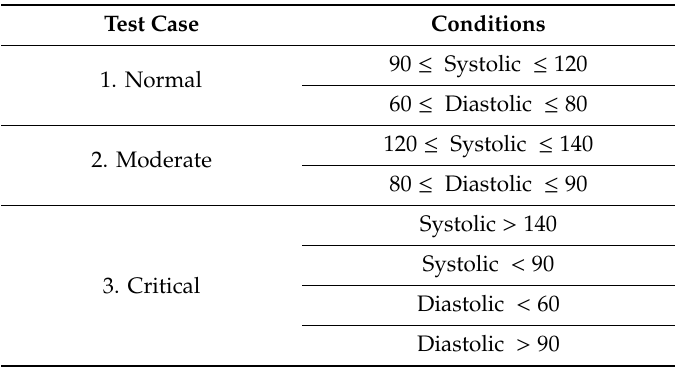
Table 2. Normal, Moderate, and Critical blood pressure